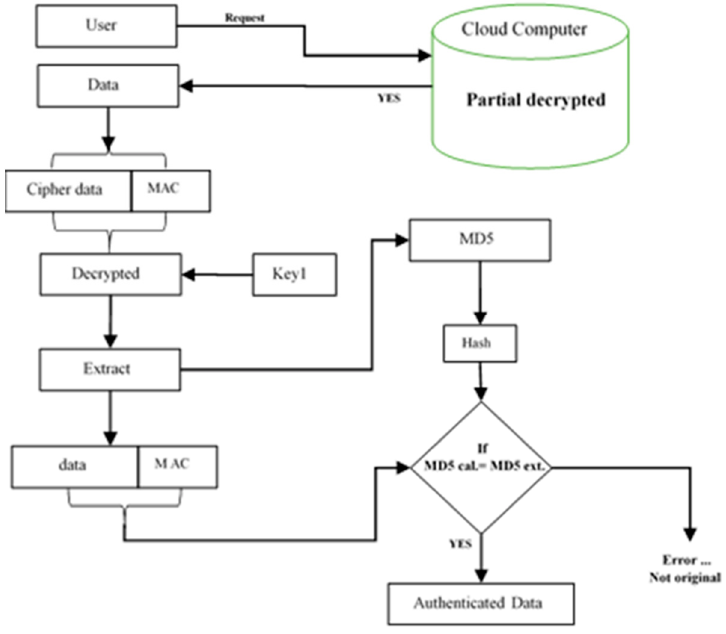
Figure 6. Download and decrypted data in the proposed system.